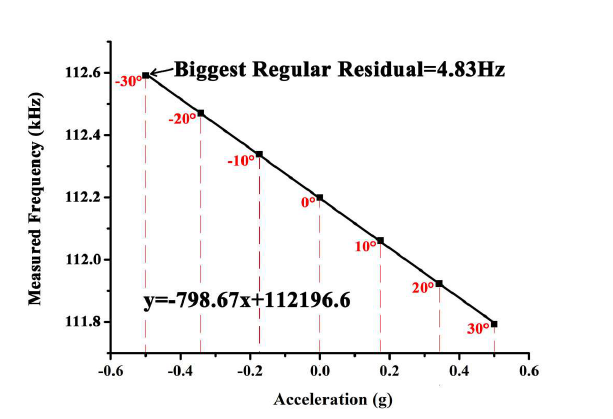
Figure 13. Linear fit of the frequency